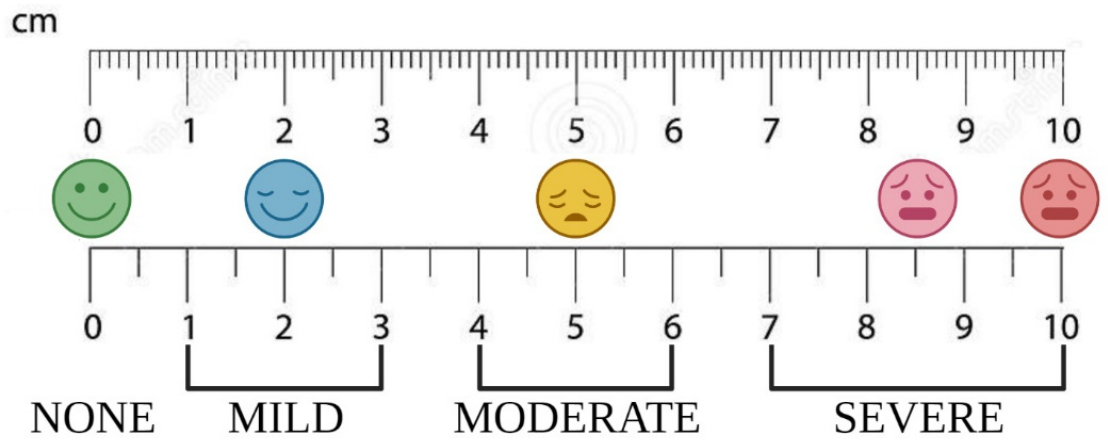
Figure 1. Visual analogue scale (VAS) evaluating the pain induced by aphtha. Image created with BioRender.com. (accessed on 1 April 2021).